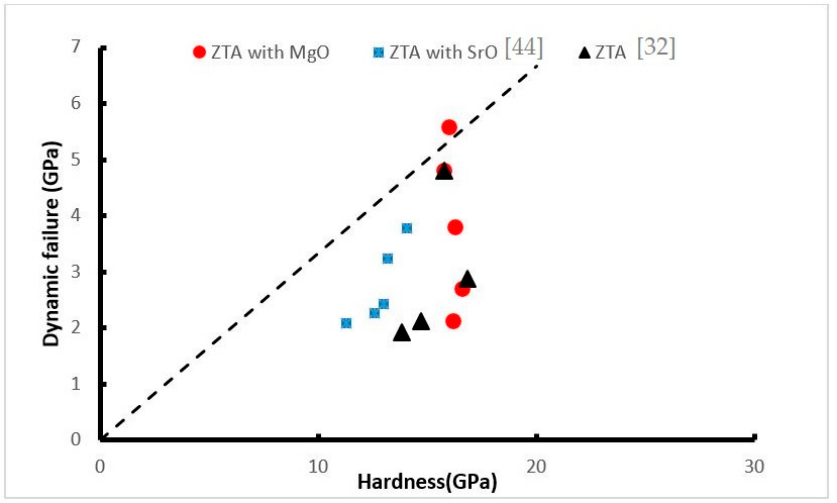
Figure 9. Relationship between the hardness and dynamic strength.